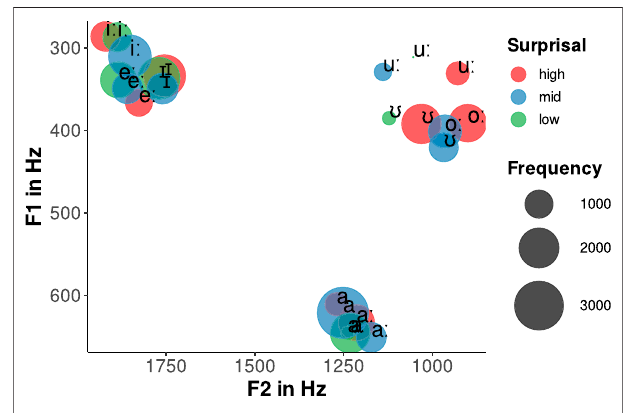
FIGURE 4 | Vowel chart of the subset of peripheral vowels with frequency of vowel tokens in the three bins of high, mid, and low biphone surprisal of the preceding context.